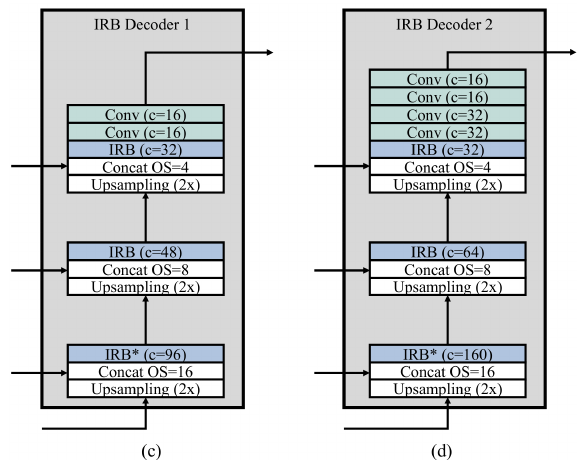
Figure 4. Structures of four comparable decoders, where OS is the output stride, c is the number of channels, and convolutions of kernel size 3 × 3 are denoted by Conv . ( a ) decoder of EAST, ( b ) decoder of CRAFT, ( c ) decoder using IRB for all stages, and ( d ) a different decoder using IRB for all stages. To ensure decoder ( d ) has a similar complexity, its expansion is set to be